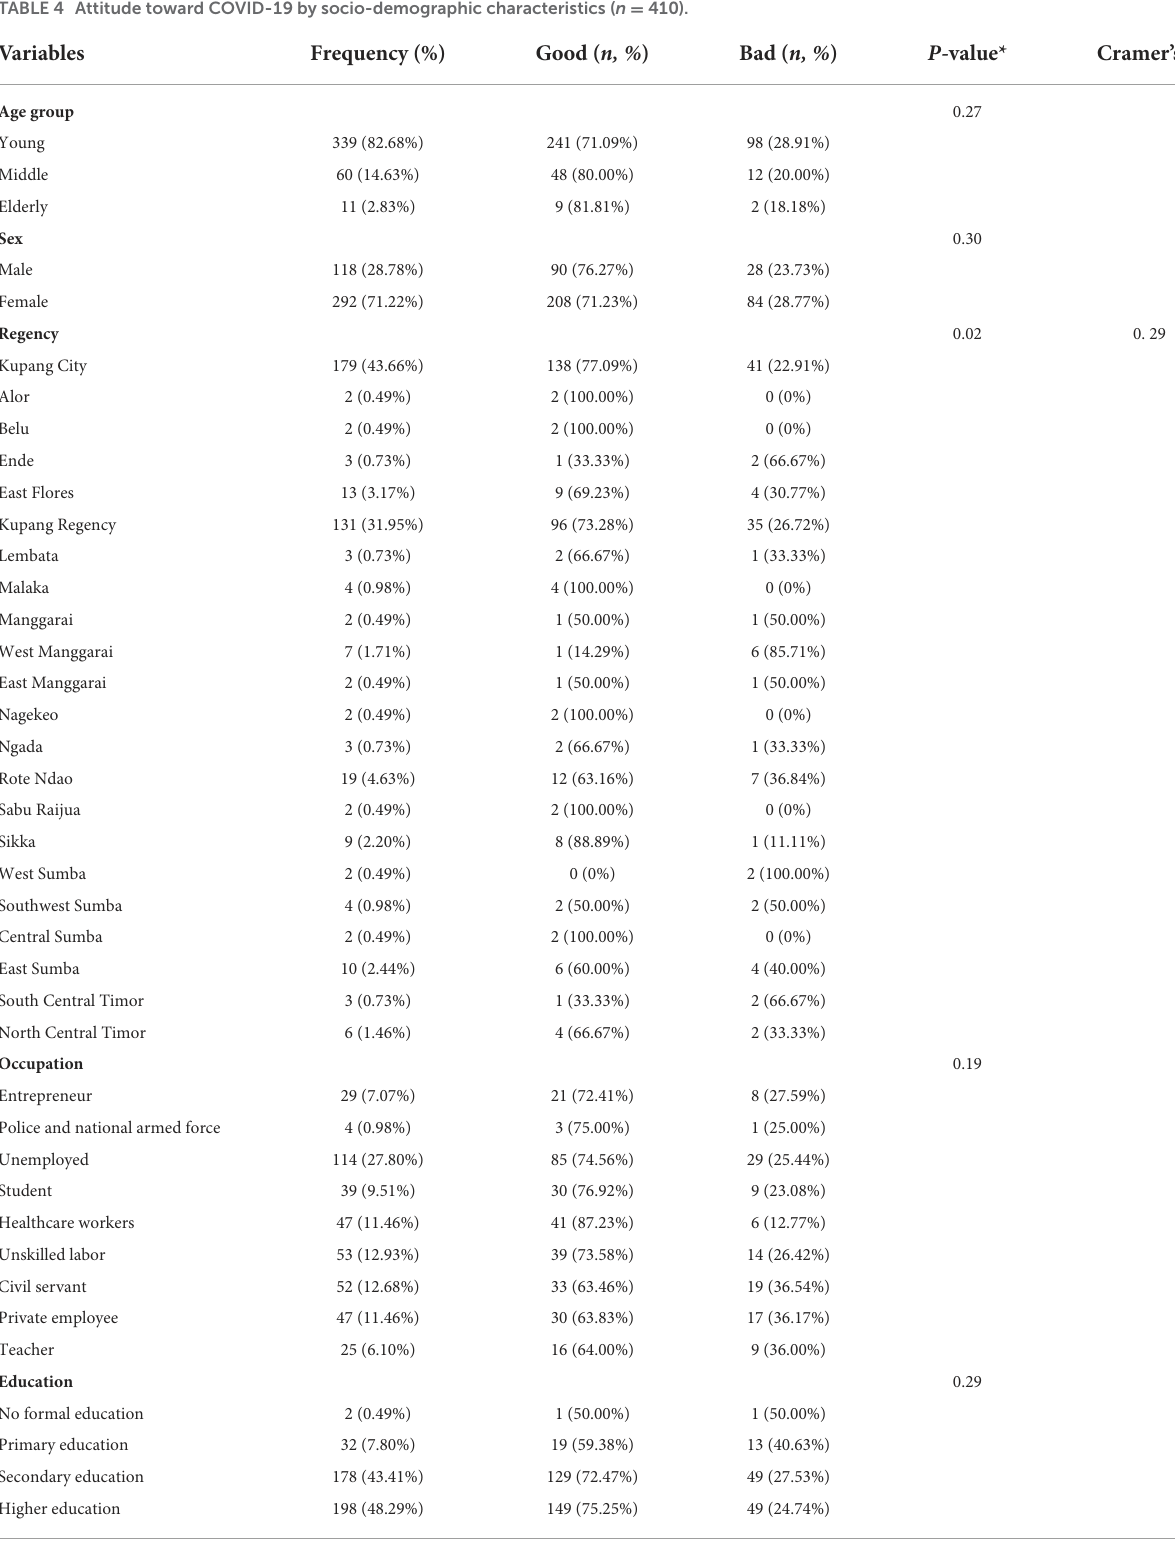
TABLE 4 Attitude toward COVID-19 by socio-demographic characteristics ( n =